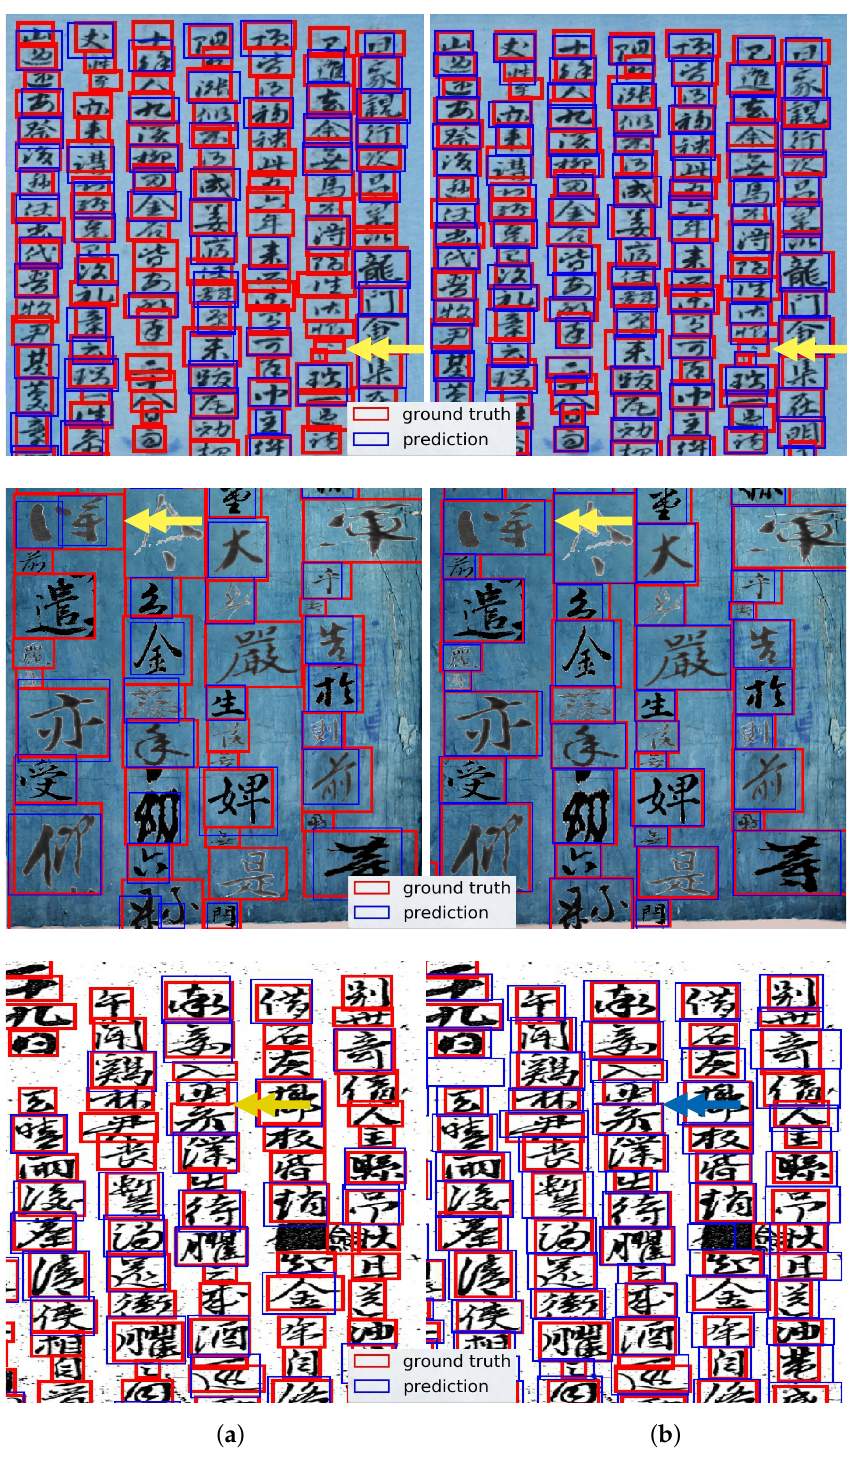
Figure 9. Detection results of conventional SSD and detection results using proposed CCB-SSD. (( a ): conventional SSD, ( b ): proposed